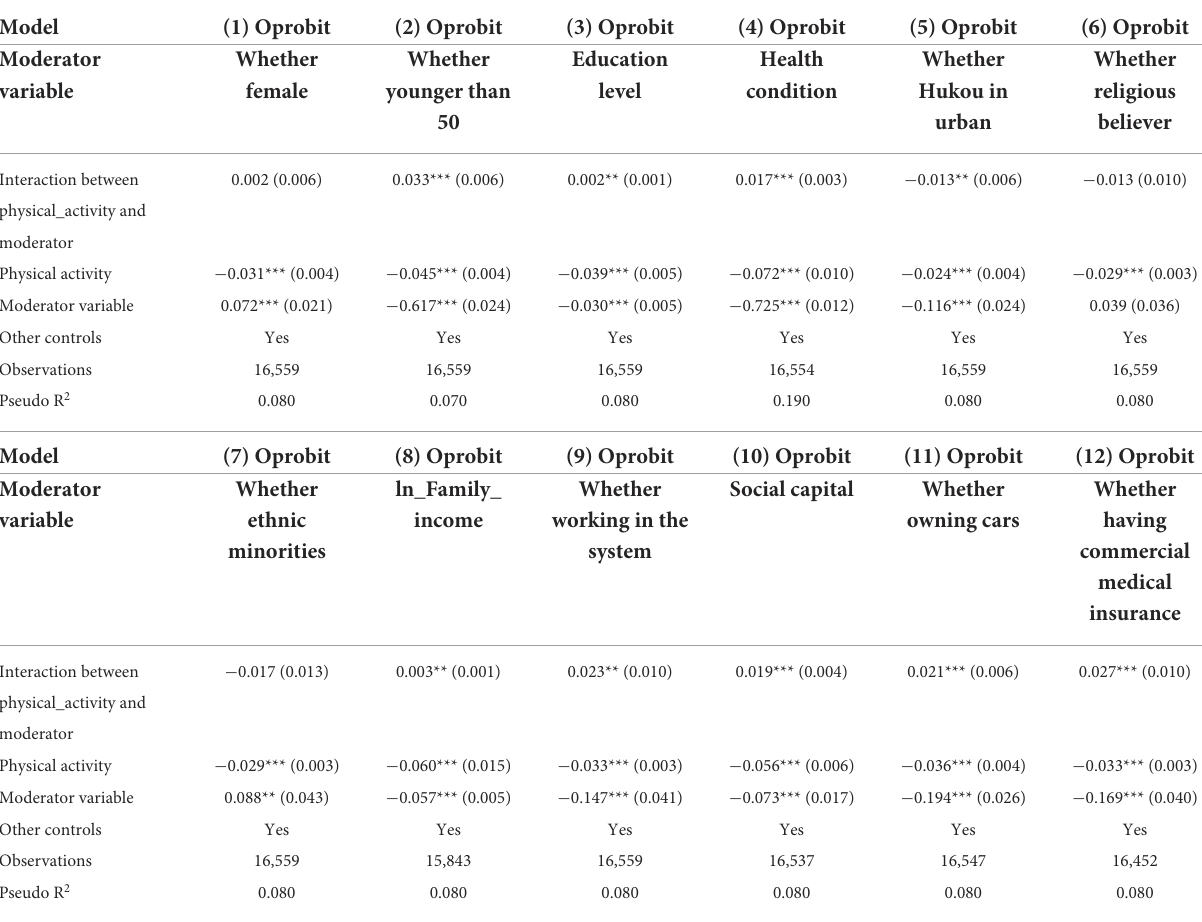
TABLE 3 Heterogeneities